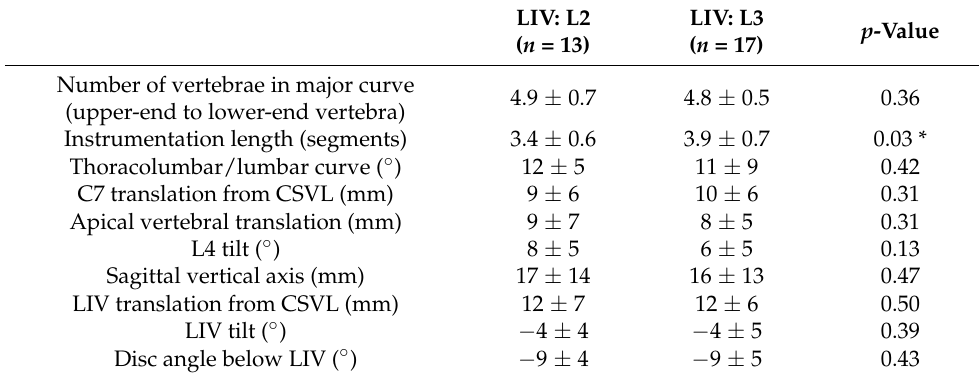
Table 7. Demographic and radiographic data of ASF cases with LIV of L2 and